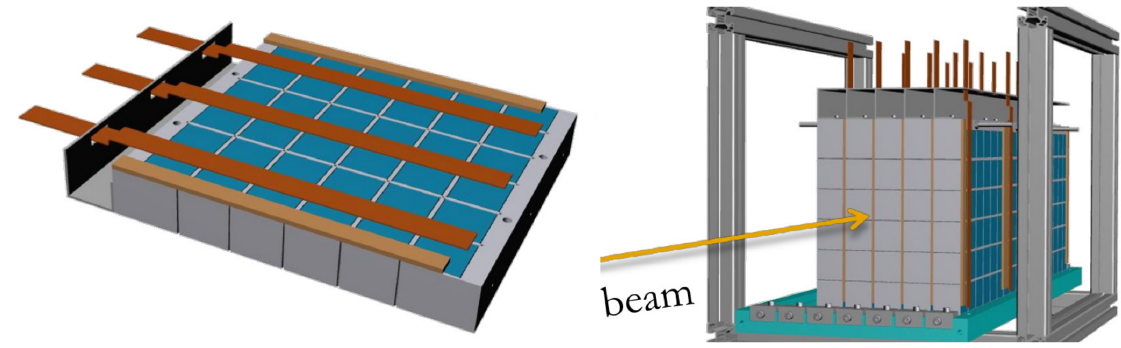
Figure 7. Conceptual design of the latest version of the CaloCube prototype built in 2016: on the left , one of the 18 layers; on the right , the complete detector.